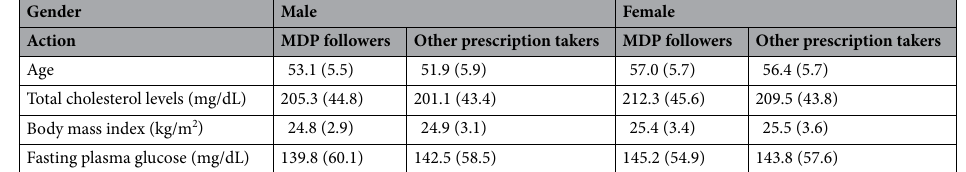
Table 8. Demographics and risk factors for 2 groups of patients with mean and standard deviation (SD) (N =